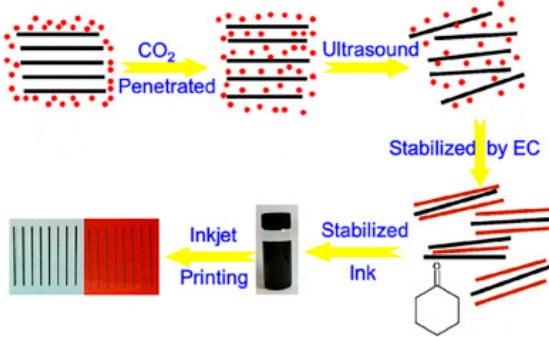
Figure 3. Schematic illustration for the preparation of pristine graphene ink using ultrasound-assisted supercritical CO 2 and its printed electrodes. Adapted with permission from Reference [82]. Copyright © 2014 American Chemical Society.